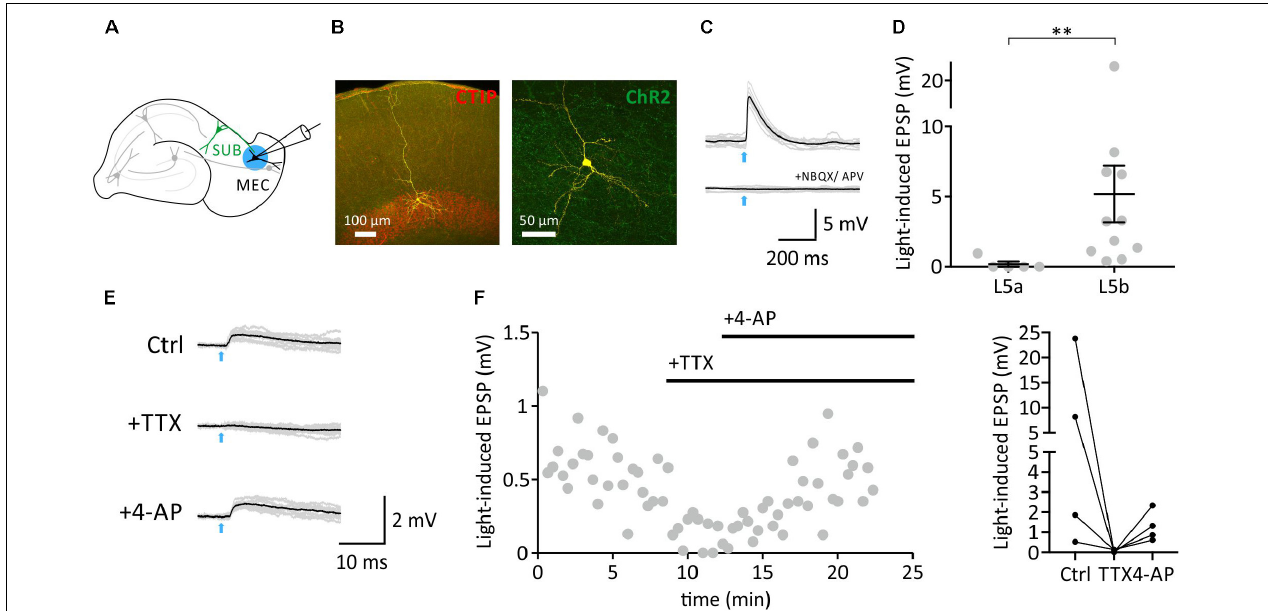
FIGURE 2 | Monosynaptic connections from the SUB to mEC L5b neurons. (A) , Schematic showing ChR2-infected burst-firing neuron in the SUB, and subsequent whole-cell recordings from mEC neuron. (B) , Anatomical reconstruction of an EC L5b pyramidal neuron. Yellow: Biocytin-streptavidin-Alexa647 signal. Red: Immunoreactivity against CTIP. Green: ChR2-YFP. (C,D) , Light-induced postsynaptic responses (EPSPs; illumination indicated by an arrow, 5 ms) of mEC L5a ( n = 5, N = 4 mice) and L5b pyramidal neurons ( D , n = 11, N = 6 mice, Mann-Whitney test, p < 0.01). (E) , Light stimulation (indicated by an arrow, 5 ms) elicited an EPSP (left), which was blocked by TTX, and rescued with 4-AP confirming monosynaptic nature of the signal. (F) , Left, time course. Right, individual 4-AP experiments ( n = 4, N = 3 mice).